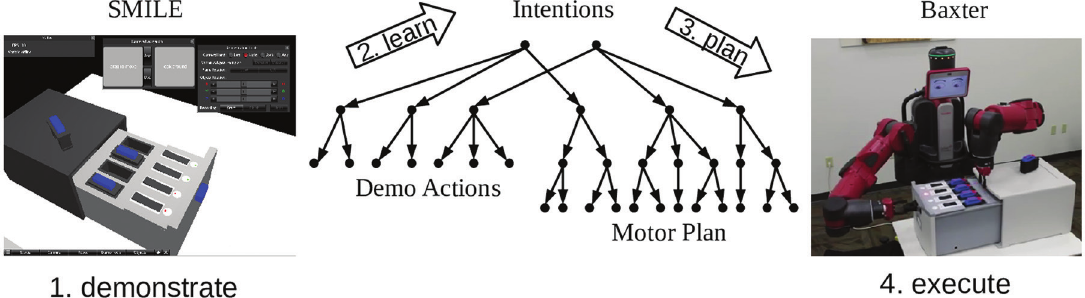
Figure 2: A sketch of CERIL’s approach to imitation learning. 1. On the left, a person demonstrates a procedure within an artificial physics-enabled world named SMILE on a typical desktop/laptop computer. Here a disk drive dock is used where a faulty disk is indicated by a red LED turning on. The demonstrator shows a sequence of steps: open the cabinet, flip the toggle switch, remove the faulty disk, discard it, pick up the new disk, etc. that restore the disk drive dock to its normal operational state. 2. A robot controlled by CERIL then uses its cause-effect relational knowledge to construct in working memory a hierar- chical explanation/interpretation of the low-level actions observed in the demonstration. The high-level sequence (“Inten- tions” in the middle panel) learned from a single demonstration represents the goals of the demonstrator, not how to copy the demonstrator’s actions verbatim. 3. Subsequently, when presented with a mock-up disk drive dock in the real world, the robot matches its internal models against objects on the table and then constructs a hierarchical plan that, when performed by the robot, will achieve the same goals as those of the demonstrator. 4. The executed plan (on the right) typically differs from that of the human demonstrator. For example, the disk to be replaced may be in a different slot, the new disk in a different location, and the robot may need to transfer a disk from one gripper to another to facilitate its insertion in the slot. The robot learns both to carry out the demonstrator’s intentions rather than copy the observed actions, and to successfully generalize from a single demonstration in this